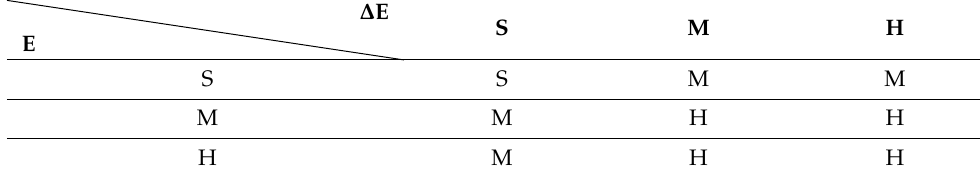
Table 1. Fuzzy rule base.